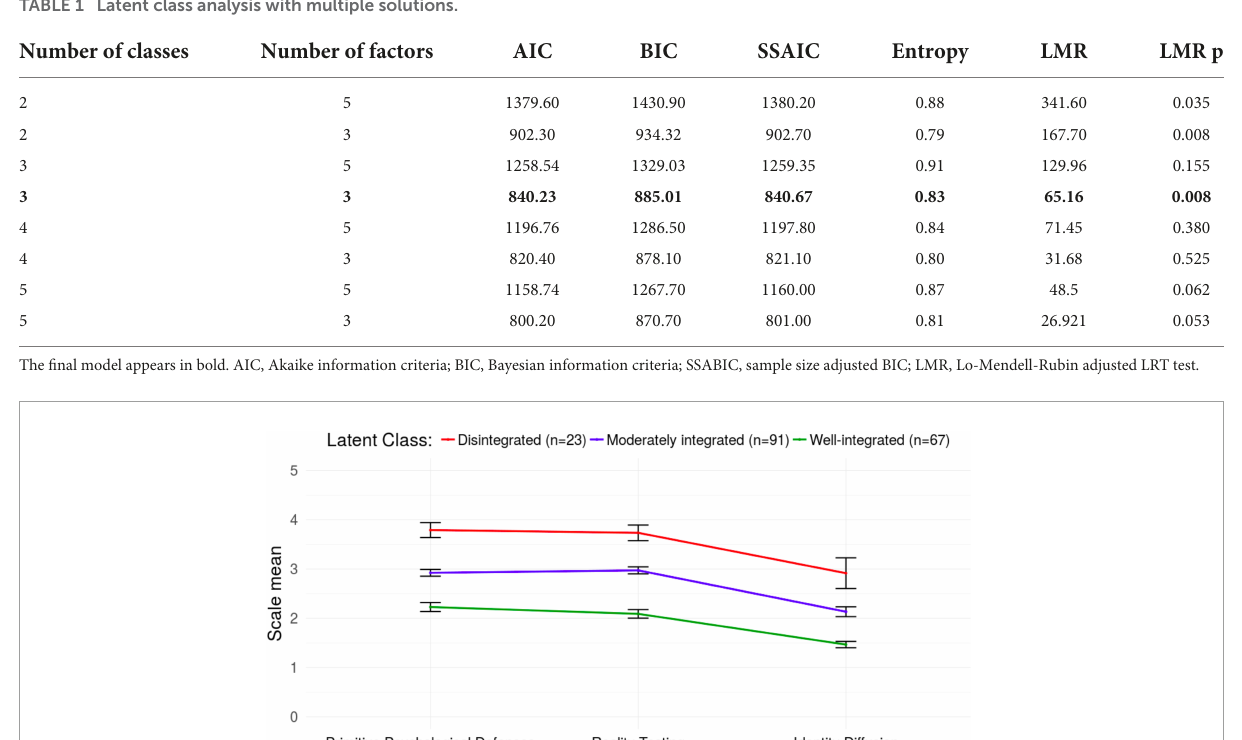
TABLE 1 Latent class analysis with multiple solutions.